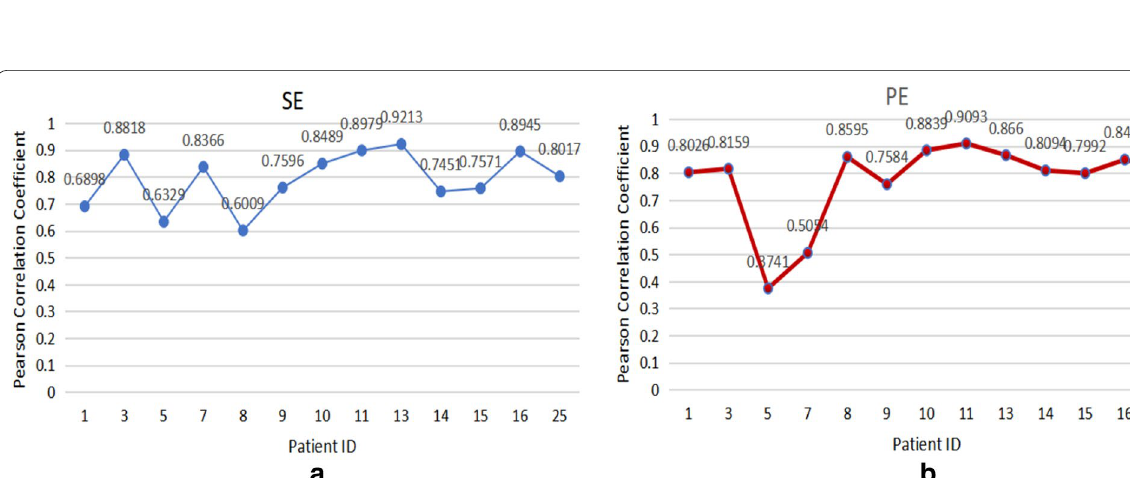
Fig. 5 r values: a SE calculated from β and βγ frequency bands vs. BIS Index; b PE calculated from γ and β1 frequency bands vs. BIS